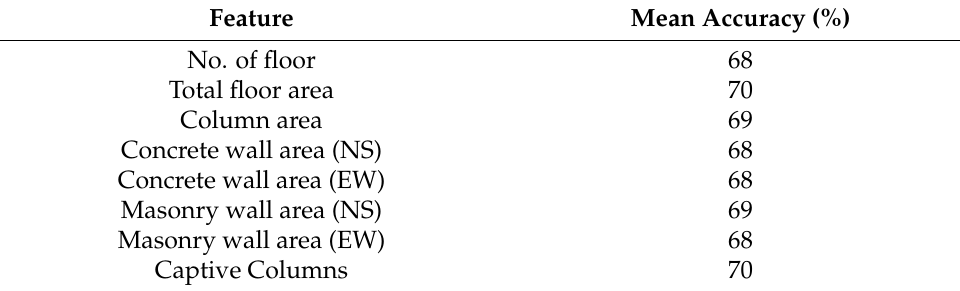
Figure 21. Nepal: Boxplot to represent the mean accuracy distribution achieved by hyper-tuning the input features. Table 10. Nepal: Predictive accuracy score against each input